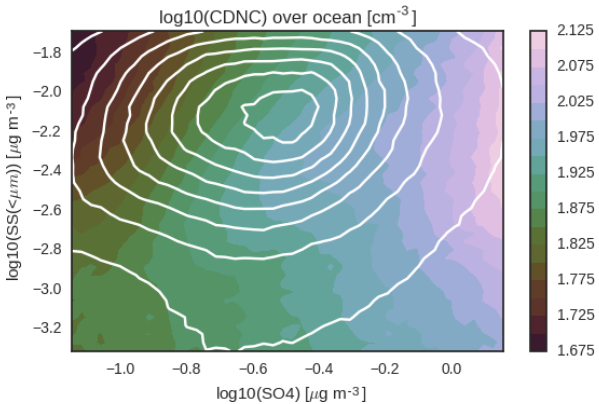
Figure 4. The dependence of CDNC on submicron sea salt and sul- fate mass predicted by MERRA2. All variables are shown in log 10 space. White lines show the probability distribution of sea salt and sulfate in the observations. Equivalent plots replacing sea salt with dust, black carbon, and organic carbon are shown in Fig.